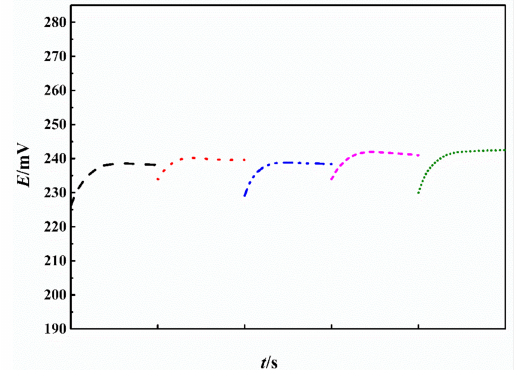
Figure 6. Potential variation of the five carbon paste electrodes of the same batch in 3.5 wt.% NaCl that contains 10 mg · dm − 3